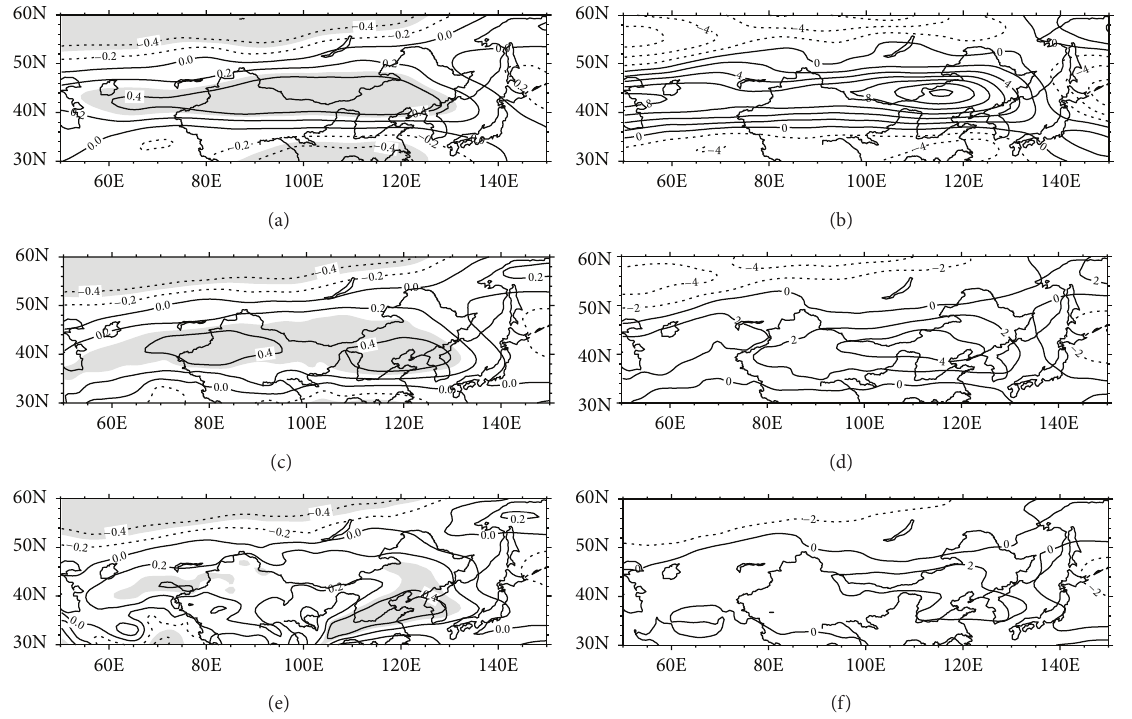
Figure 7: The correlation coefficient distribution between the total HDs in region A and u-component anomaly (m/s) at (a) 250 hPa, (c) 500 hPa, and (e) 700 hPa during 1979–2013 summer, and the distribution of u-component anomaly of (b) 250 hPa, (d) 500 hPa, and (f) 700 hPa in the summer of 2013. In (a, c, and e), the long-term trend is removed, and shaded area denotes the correlation coefficient significant at the 0.05